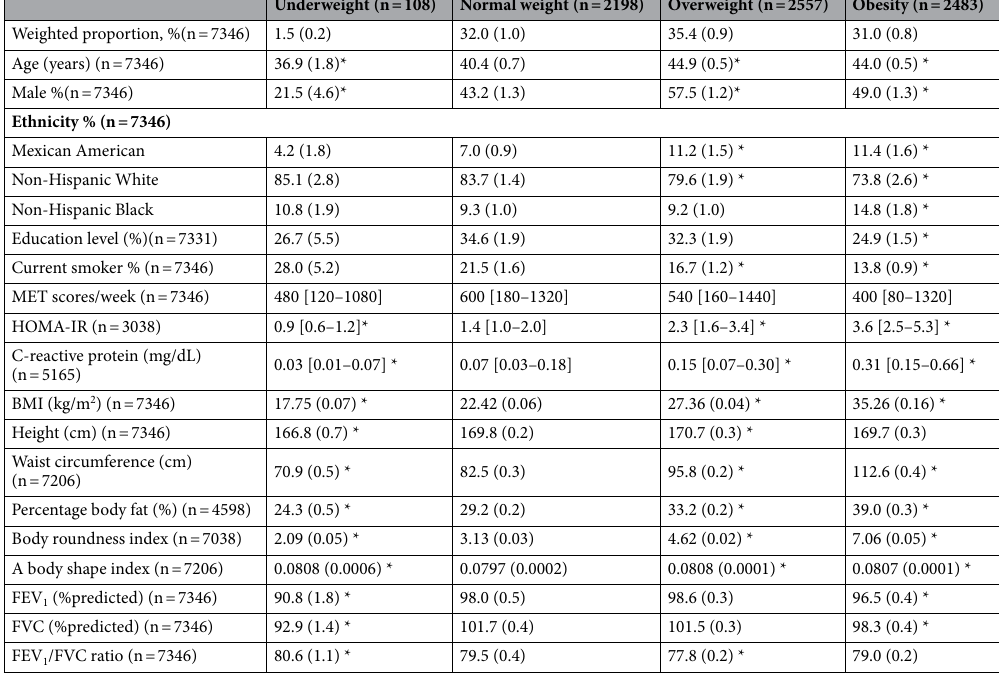
Table 1. Cross-sectional characteristics of participants. Data were weighted estimates and expressed as mean (standard error) or median [percentile 25–percentile 75] (n = number of participants in analysis). Education level, percentage of participants, completed college graduate or above. HOMA-IR homeostasis model of assessment for insulin resistance index, MET score metabolic equivalent scores per week. *p < 0.05 compared to normal weight.